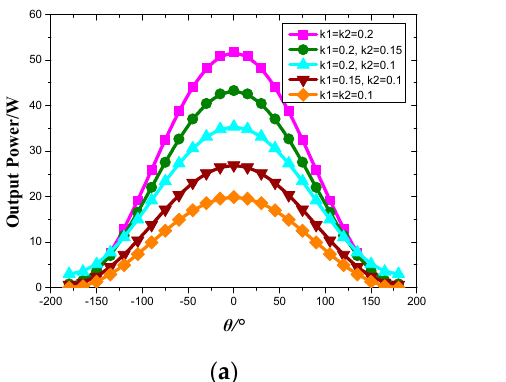
Table 2. Main simulation parameters of PS-type DEU-WPT system.